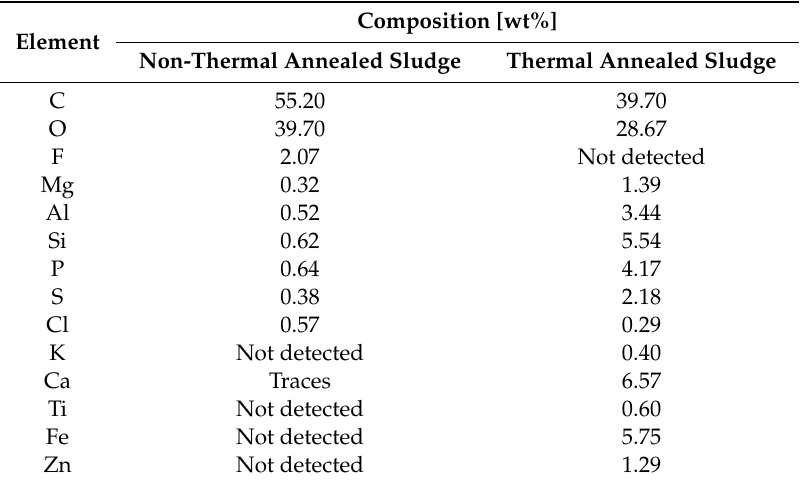
Figure 6. Energy Dispersive X-ray (EDX) analysis of ( a ) non-thermal annealed and ( b ) thermal annealed sludge derived biochar at different magnifications. Table 1. Elemental composition of carbonized sludge and annealed sludge.